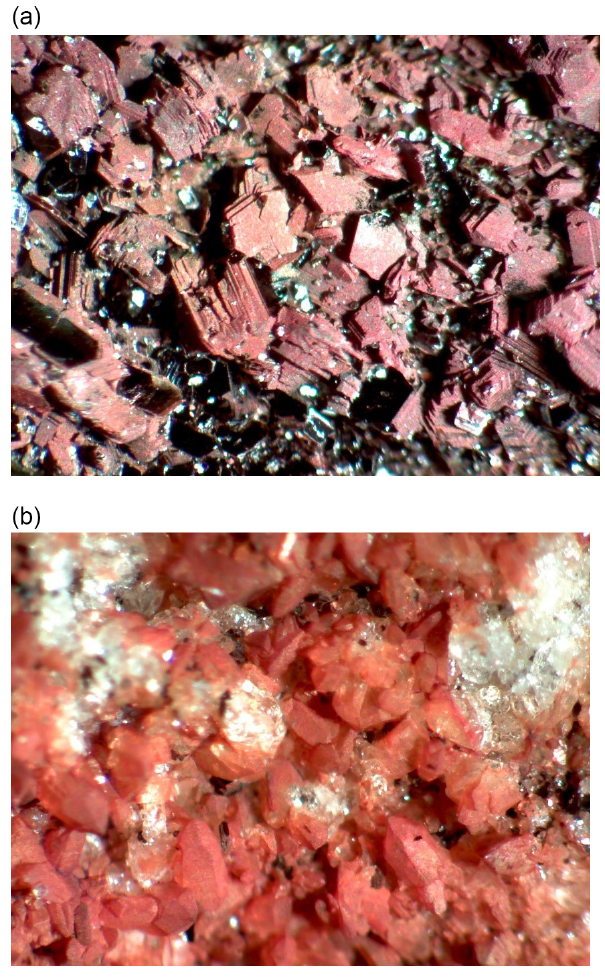
Figure 8. (a) Euhedral hydrothermal biotite books, approximately 1mm across, coating fracture surface in RN-15/IDDP-2 (4637.81m depth). Exposed crystals were stained red by hematite during the coring operation. (b) Open-space filling quartz, up to 4mm in length, overgrowing hydrothermal biotite (black crystals) in RN- 15/IDDP-2 (4637.81m depth). Exposed crystals were stained red by hematite during the coring